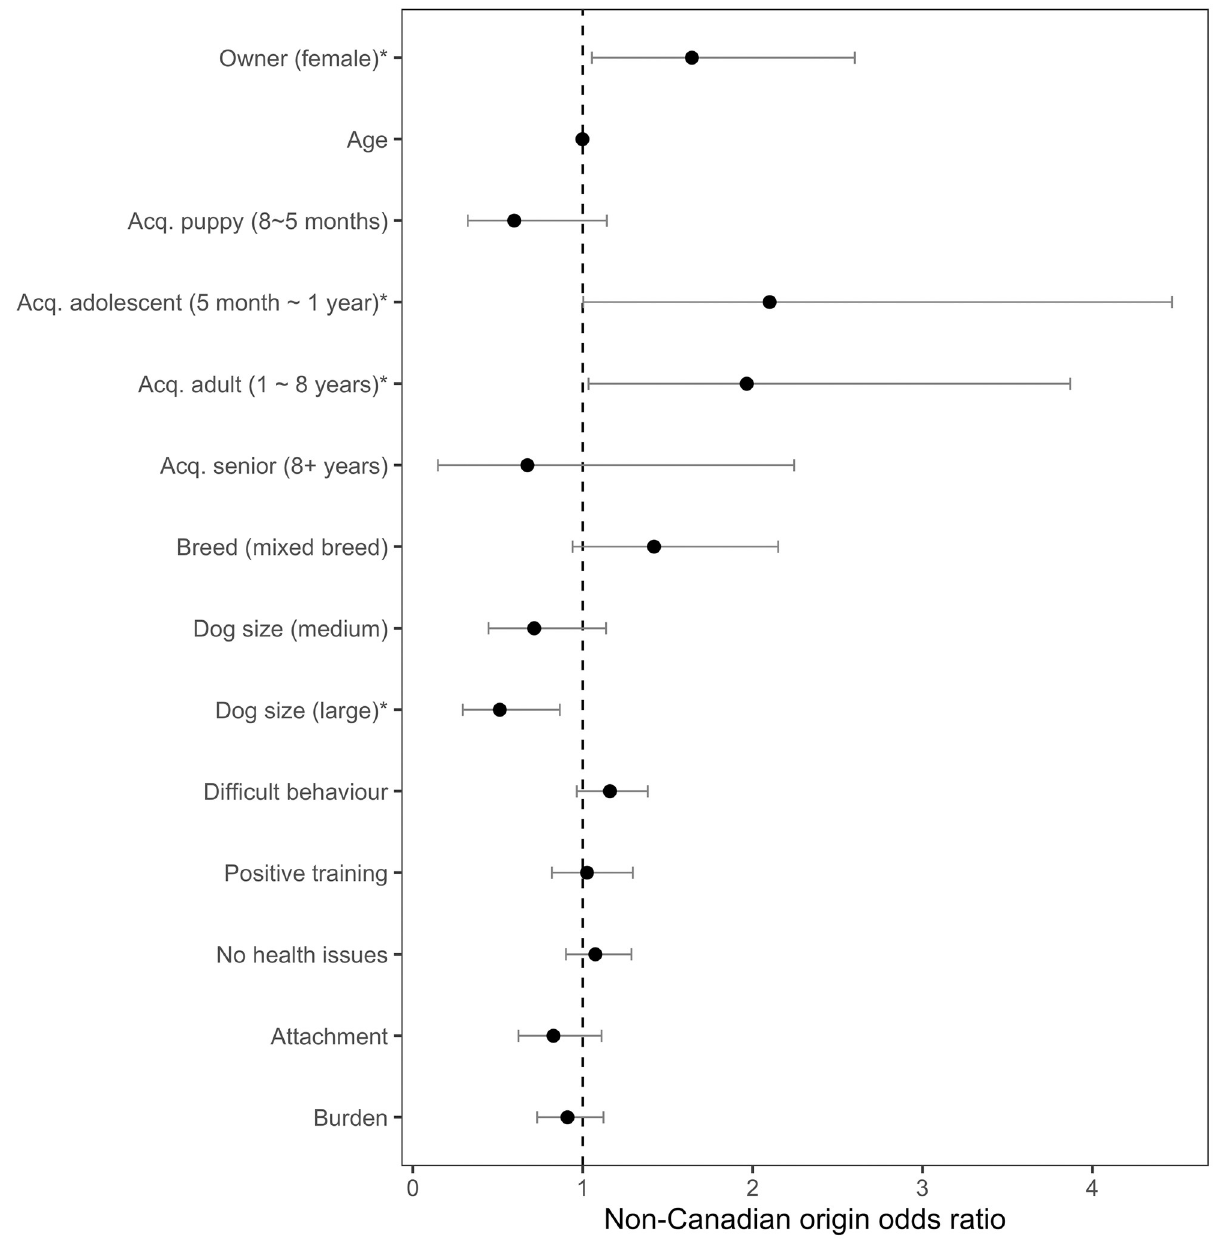
Fig 4. Non-Canadian origin outcome odds ratio for owner and dog parameters. Non-Canadian origin outcome odds ratio predicted by all variables collected: owner gender (female), owner age, age of dog when acquired, dog breed (mixed), dog size, and owner-dog dimensions, calculated by the logistic regression model. Statsitcal signifiance was detected when 95% confidence interval did not cross the dotted line at odds 1. Statistically significant variables are indicated with an asterisk.